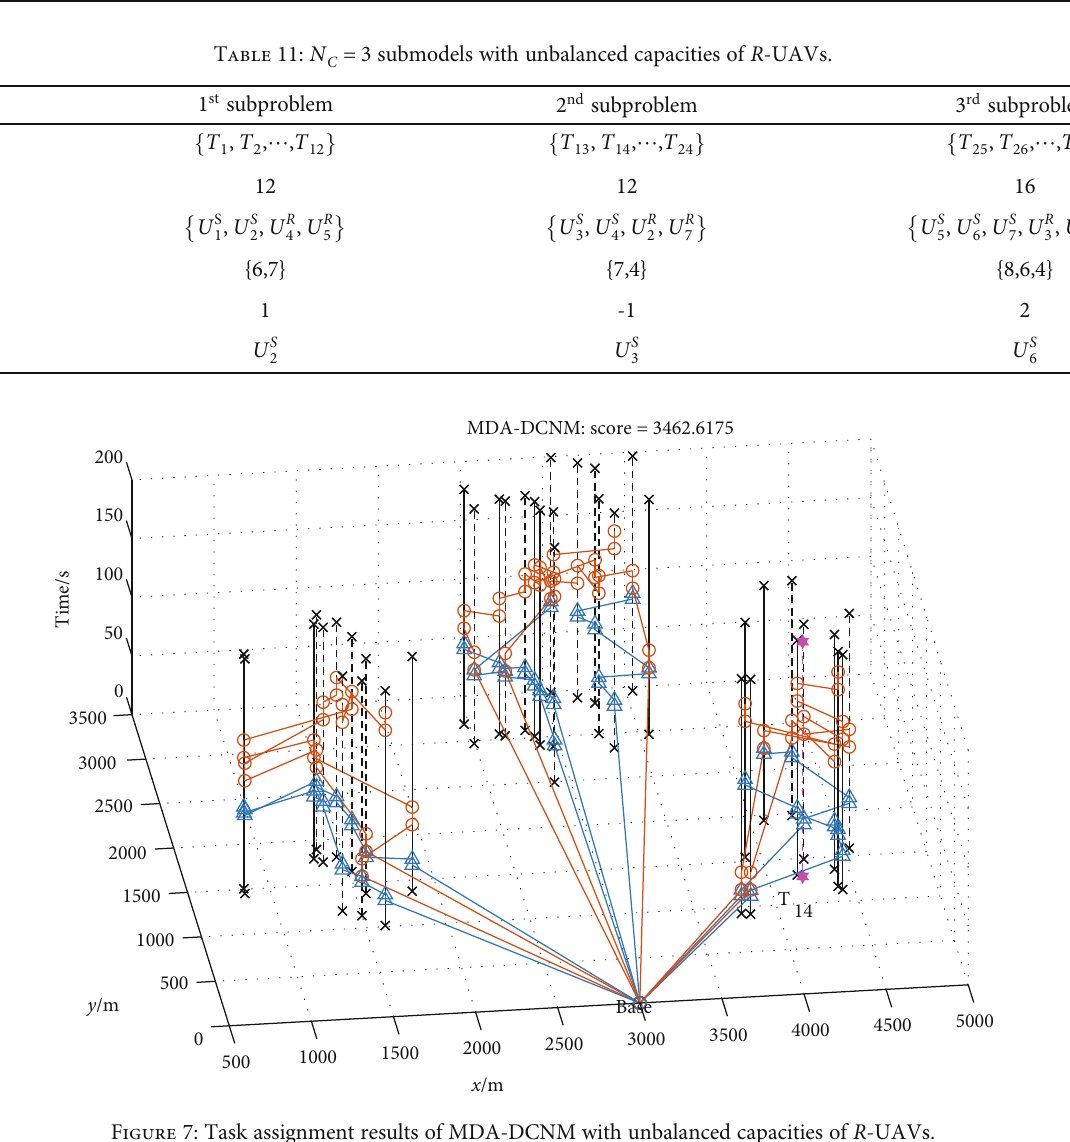
Table 11: N C = 3 submodels with unbalanced capacities of